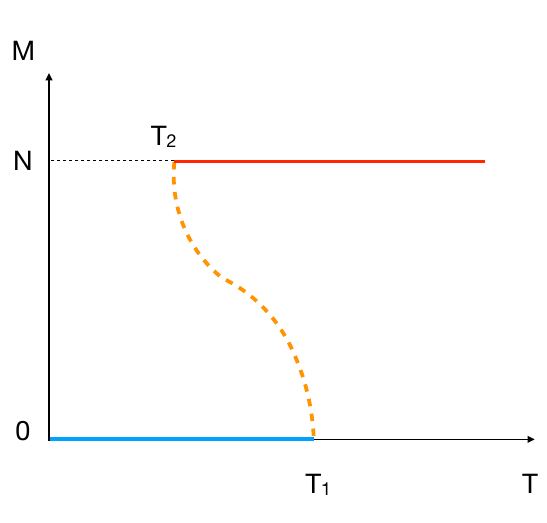
Figure 14. In the theories with a (cid:12)rst order phase transition, there is an unstable saddle (maximum of the free energy) with negative speci(cid:12)c heat in the canonical ensemble. In this phase, the SU( M ) subgroup of the SU( N ) gauge group is decon(cid:12)ned. This phase connects two stable phases, the con(cid:12)ning phase (blue line) and the completely decon(cid:12)ning phase (red line).